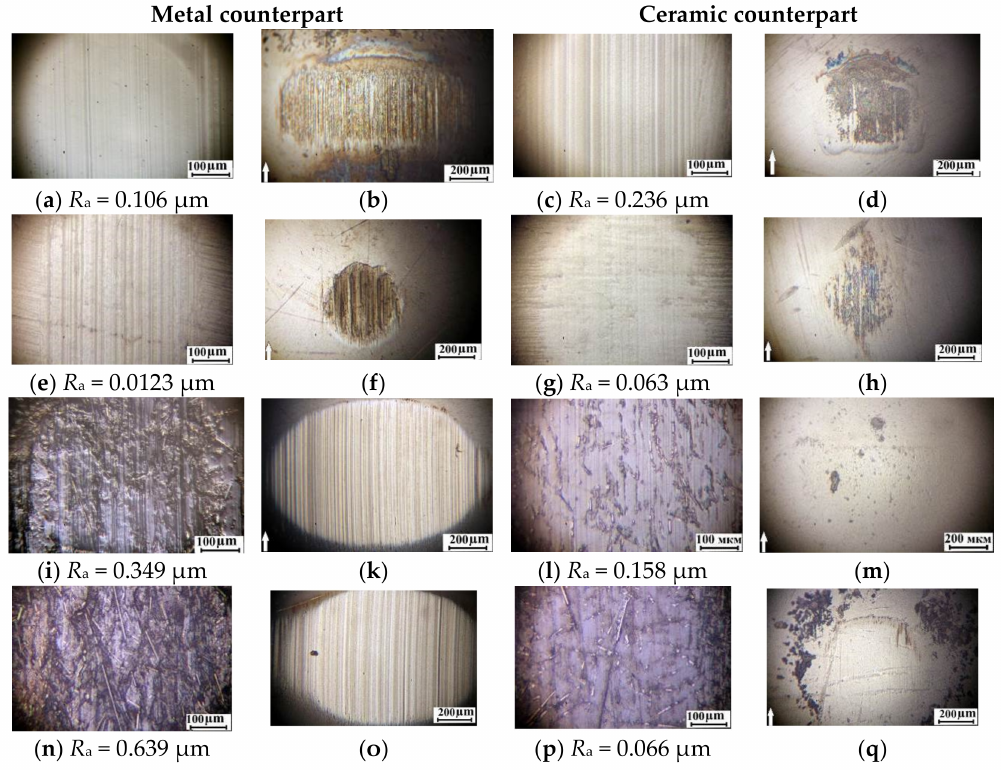
Figure 10. Optical images of the wear track (sample) surfaces and the counterparts at the steady state wearing stage: ( a – d ) PPS, ( d – q ) PPS-based composites (( e – h ) PPS + 15% PTFE, ( i – m ) PPS + 20% CF, ( n – q ) PPS + 15% PTFE + 22.5%